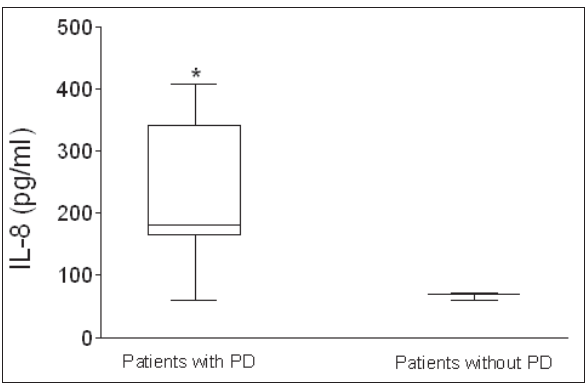
Fig. 2 - Levels of IL-8 in plasma of peripheral blood of Down’s syndrome patients with and without periodontal disease. The concentration of IL-8 was evaluated by ELISA. The results are expressed as means ± standard error of means of the values of at least two experiments. *Statistically significant difference (p<